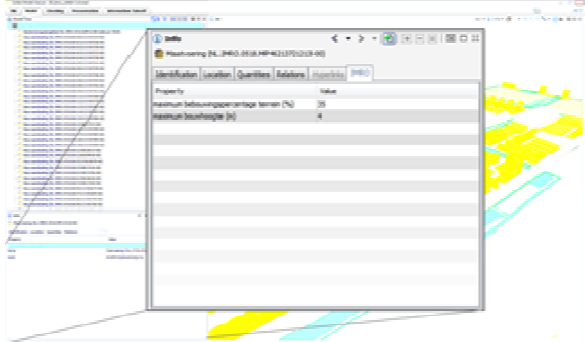
Figure 5. Attributes of the spatial objects are retained in the conversion from geo-information to BIM